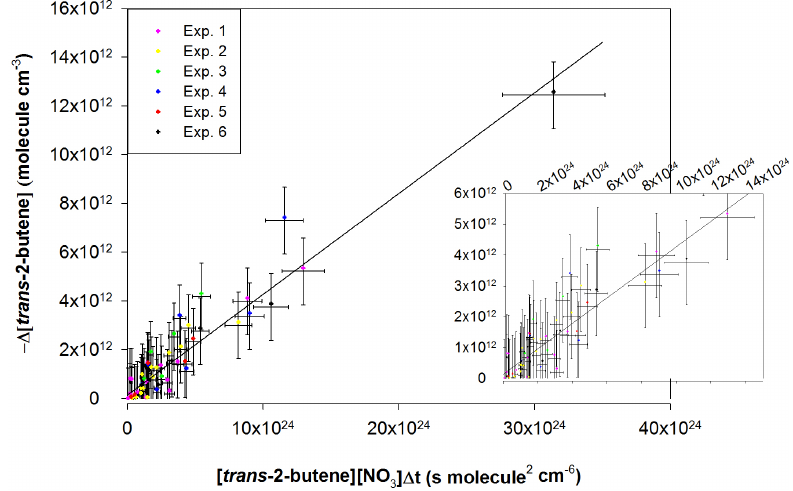
Figure 8. Absolute kinetic plot for the reaction of trans -2-butene with NO 3 radicals, showing the loss of trans -2-butene vs. [VOC] × [NO 3 ] × (cid:49)t . The inset on the right shows a close-up of the points close to the